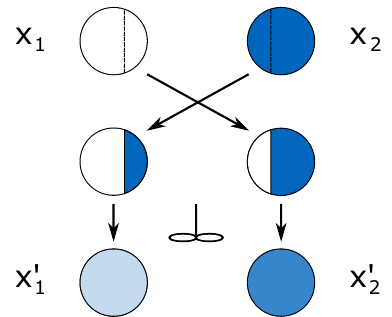
Figure 6. Illustration of concentration exchange between two droplets according to the newly formulated model; darker shades of blue correspond to higher values of the concentration measure x